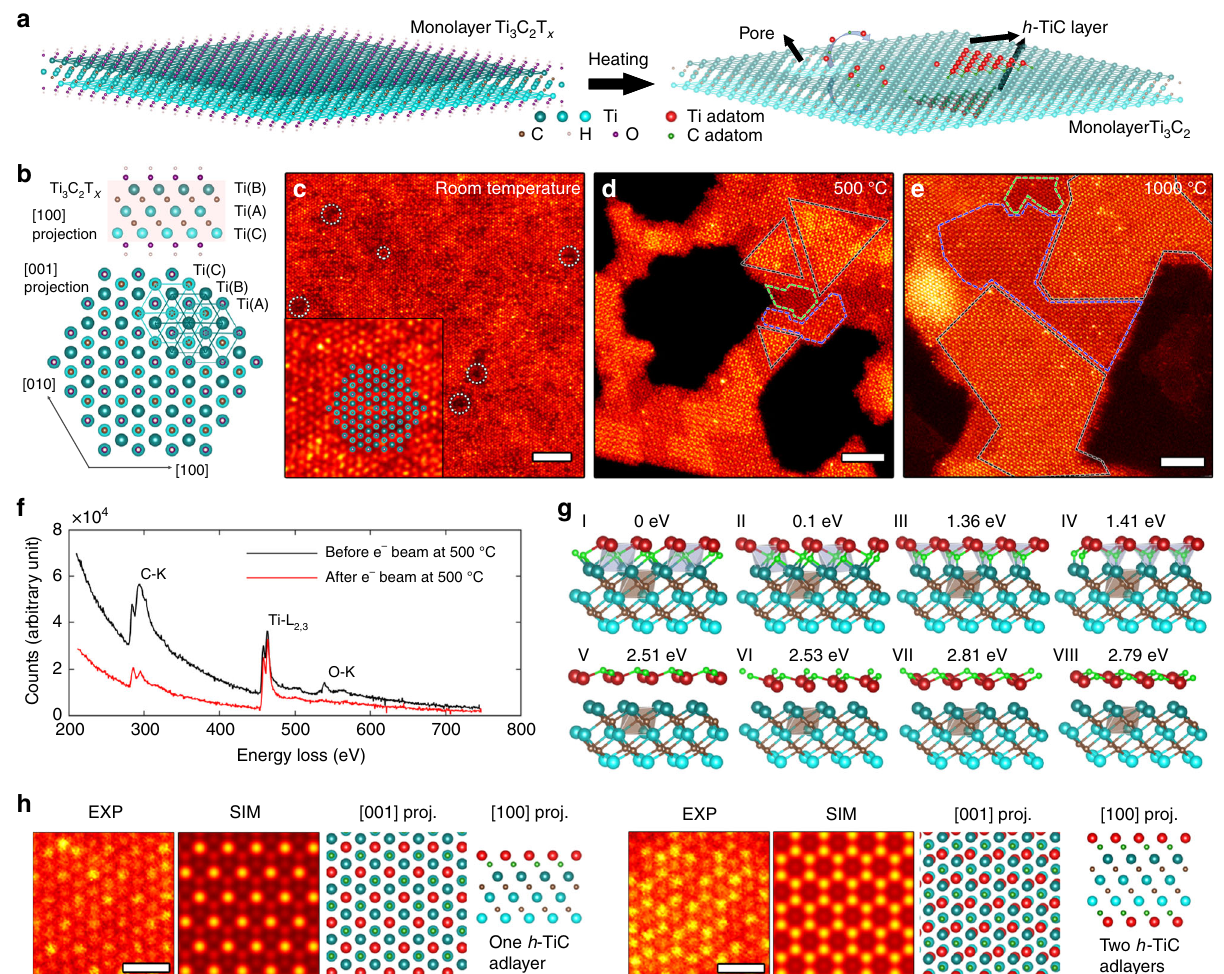
Fig. 1 Homoepitaxial growth of MXene. a Schematic of the homoepitaxial growth process to form single layer h -TiC on a monolayer Ti 3 C 2 substrate through electron-beam irradiation and heating. Ti atoms from different layers are plotted using different shades of blue. b Crystal structure of monolayer Ti 3 C 2 T x viewed from [100] and [001] zone axes. c Atomic resolution STEM image acquired from monolayer Ti 3 C 2 T x along the [001] zone axis at room temperature. Areas of Ti vacancies are indicated by white dotted circles. Inset shows comparison between atomic resolution STEM image and projected crystal structure of Ti 3 C 2 T x . d A STEM image acquired after heating and electron-beam irradiating monolayer Ti 3 C 2 fl akes inside the microscope at 500 °C. The black areas are pores, while areas framed by green, blue, and black dashed lines are the substrate (Ti 3 C 2 ), nanoscale areas of single h -TiC adlayer on one surface (Ti 4 C 3 ), and nanoscale areas of single h -TiC adlayers on both surfaces (Ti 5 C 4 ), respectively. e A STEM image acquired after heating MXene fl akes inside the microscope at 1000 °C. f EEL spectra before and after e-beam irradiation at 500 °C for the C-K edge at 284 eV, Ti-L 2,3 edge at 456 eV, and O-K edge at 532 eV. g Perspective view of eight different stacking con fi gurations (I-VIII) of h -TiC adlayer on a Ti 3 C 2 substrate. The relative total energy (eV) to the ground state (I) is shown for each structure. h Experimental (EXP) and simulated (SIM) STEM images of Ti 4 C 3 and Ti 5 C 4 , and the corresponding crystal structures projected along [001] and [100] zone axes. The scale bars in c – e are 2 nm, while the scale bars in h are 0.5 Ti-vacancy (3-V Ti ) cluster as indicated by dashed white circles in Fig. 2a. The 3-V Ti cluster is likely formed by the removal of three adjacent Ti atoms from one of the surface layers during chemical etching 27 . The Ti vacancy cluster grows as Ti atoms migrate onto the surface (Fig. 2b, c). The remaining Ti atoms in the center rearrange to adopt the minimum energy state and eventually there are only enough Ti atoms to form a single Ti layer in the center (Fig. 2d). From Fig. 2d – f, the central Ti atom (indicated by the green circle) fi nally diffuses away. The Ti single layer area immediately collapses, and then a vacuum pore continues to expand as shown from Fig. 2g – i.